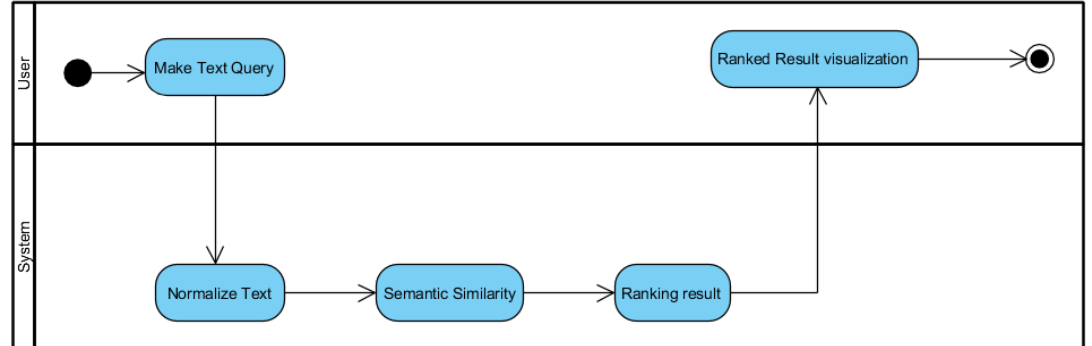
Figure 5. Activity diagram: Textual query (Case A).